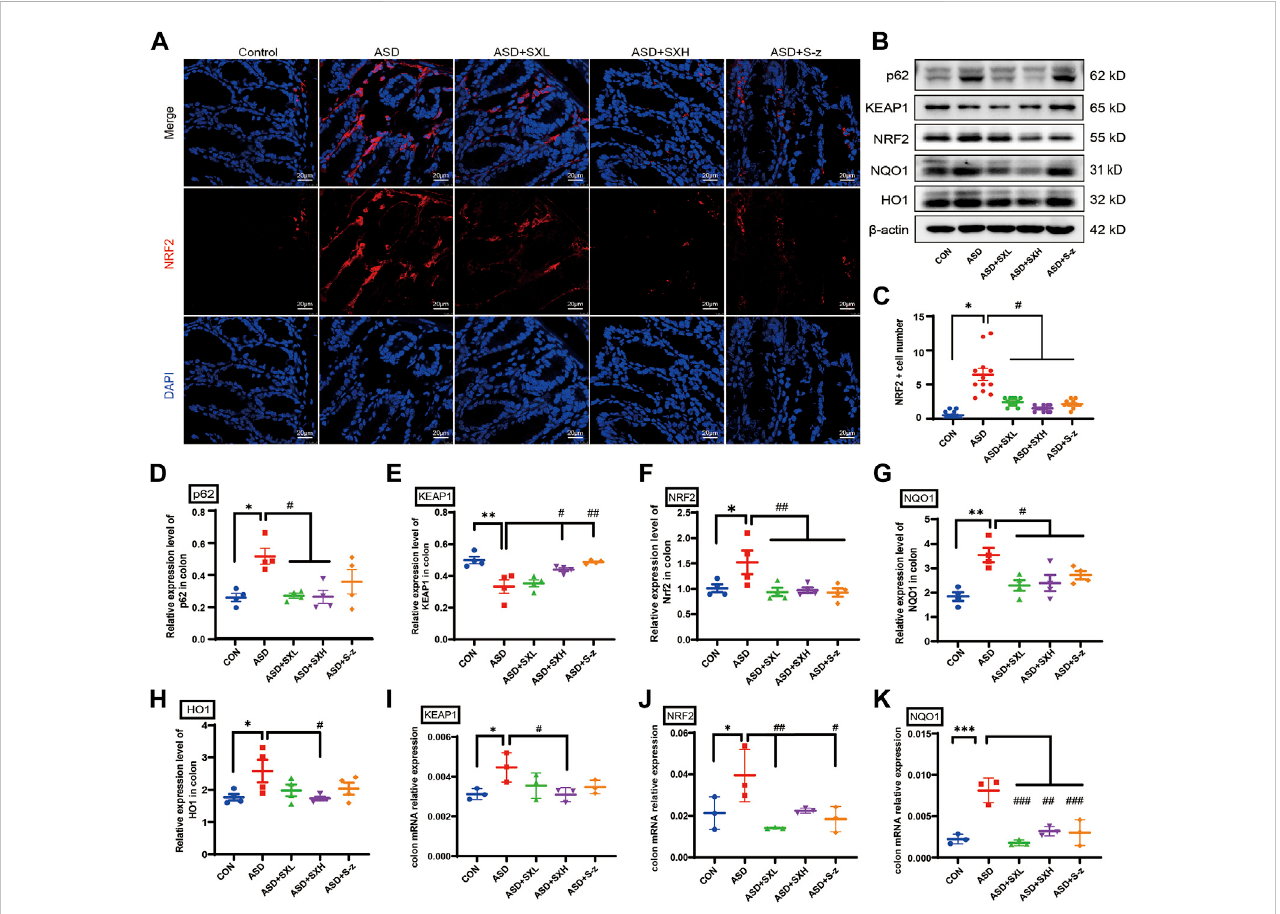
FIGURE 5 SX modulates ASD-induced oxidative stress in the colon through the p62/KEAP1/NRF2/HO1/NQO1 signaling pathway. (A) Representative immuno fl uorescence images show thelocalization ofNRF2proteininthecolon sectionsbased on stainingwith the fl uorophore-labeled anti-NRF2antibody (red fl uorescence). The nuclei are stained with DAPI (blue fl uorescence). (B) Representative western blot shows the expression levels of p62, KEAP1, NRF2, NQO1,HO1,and β -actinproteinsinthecolonsofmicebelongingtotheCON,ASD,ASD+SXL,ASD+SXH,andASD+S-zgroups. β -actinwasusedasthe internalloadingcontrol.Theexperimentwasrepeatedthreetimes. (C) ThedotplotshowsthenumbersofNRF2positivecells(basedonimmuno fl uorescence staining in A) in the colonic mucosa of mice belonging to the CON, ASD, ASD + SXL, ASD + SXH, and ASD + S-z groups. p < 0.05, ASD vs. SXL, SXH, and S-z. (D – H) The relativeexpression levels of p62, KEAP1, NRF2, NQO1, and HO1 proteins comparedto the β -actin protein levels in the colons of mice belonging to the CON, ASD, ASD + SXL, ASD + SXH, and ASD + S-z groups. Note: for p62 in (D) , p < 0.05, ASD vs. SXL, SXH; p = 0.4302, ASD vs. S-z); for KEAP1 in (E) , p < 0.05 ASD vs. SXH; p < 0.01 vs. S-z); for NRF2 in (F) , p < 0.01, ASD vs. SXL, SXH, and S-z); for NQO1 in (G) , p < 0.05, ASD vs. SXL, SXH, and S-z; for HO1 in (H) p